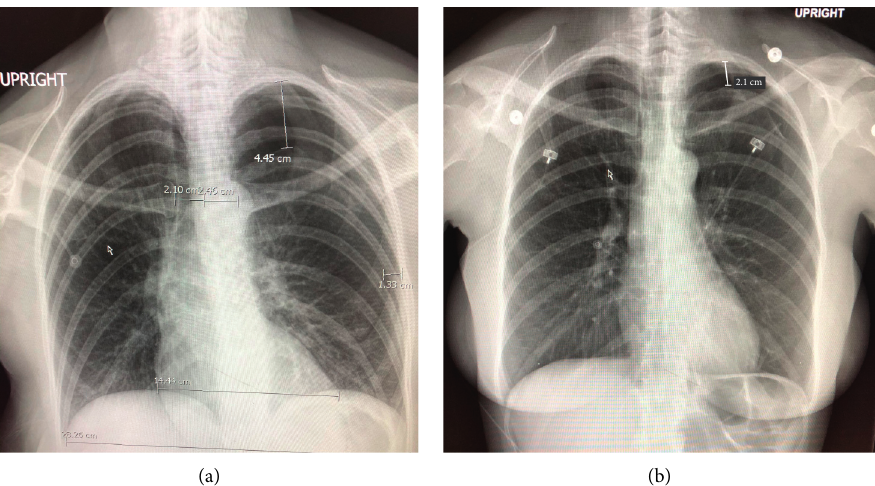
Figure 1: (a) Initial CXR in the emergency department showing a left pneumothorax measuring 4.45cm separation of the pleura at the apex and 1.33cm laterally. (b) Repeat CXR on postprocedure day 1 with 2.1 cm separation of pleura at the apex.